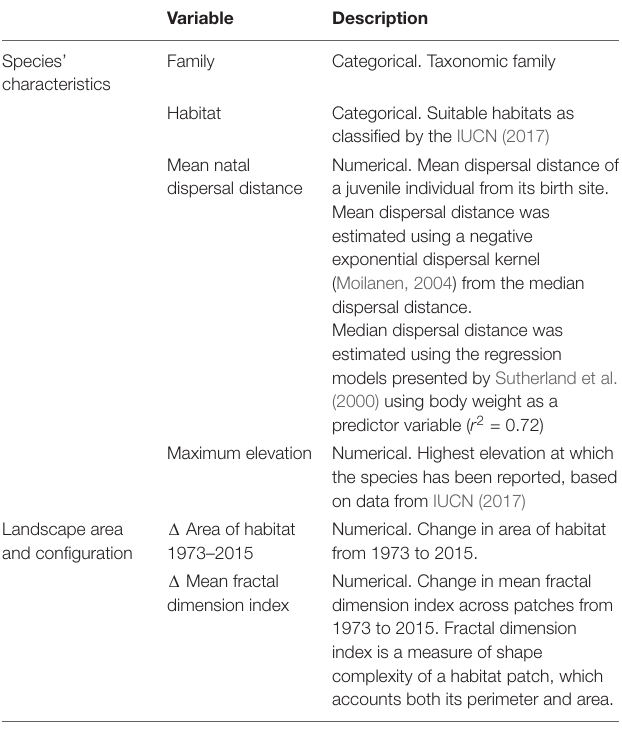
TABLE 1 | Explanatory variables considered in the Generalized Linear Mixed Model to explain the change in Equivalent Connected Area (ECA) from 1973 to 2015 for 245 forest mammals and birds on